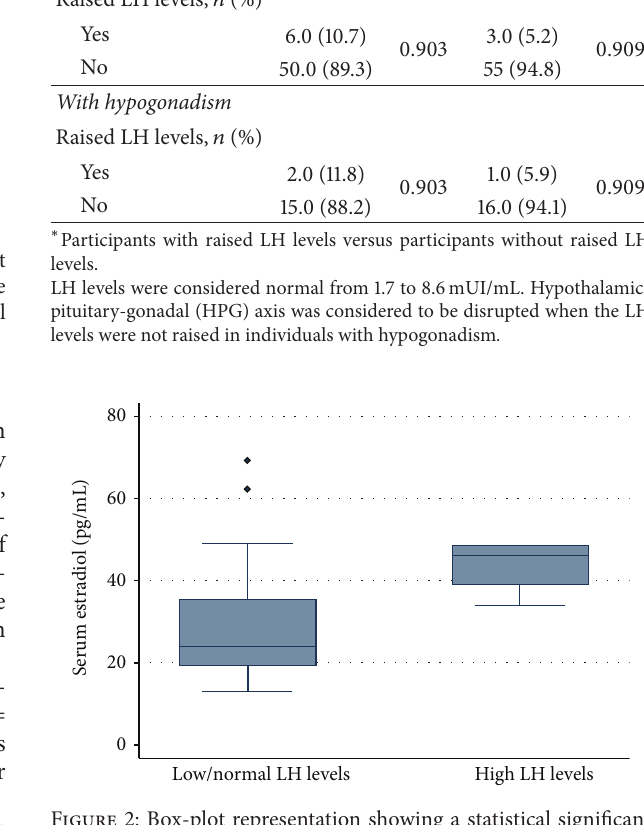
to dissimilarities in LH levels ( 𝑃 = 0.033 ). In these